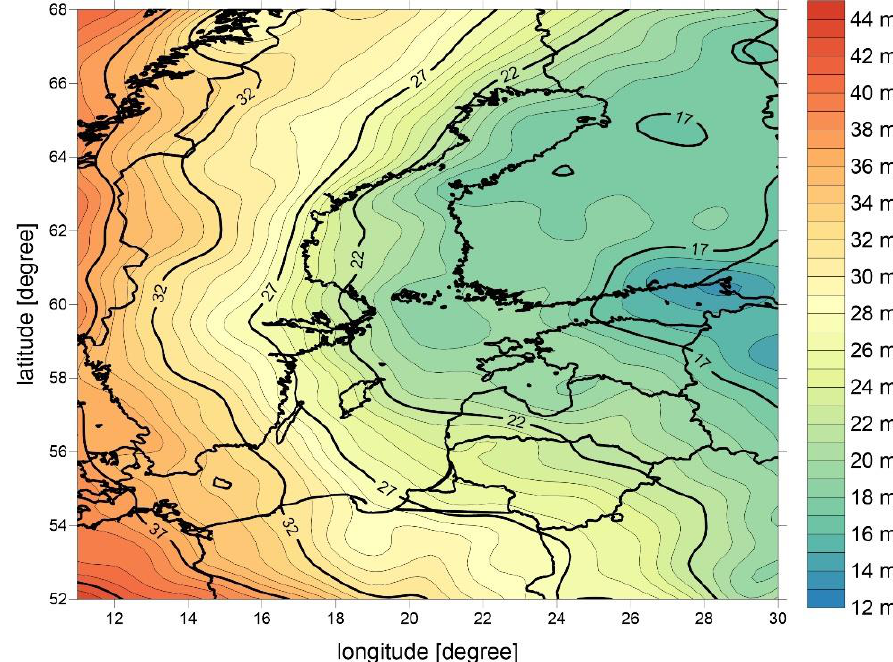
Figure 5. Geoid, in meters, computed from GOCO06s model.